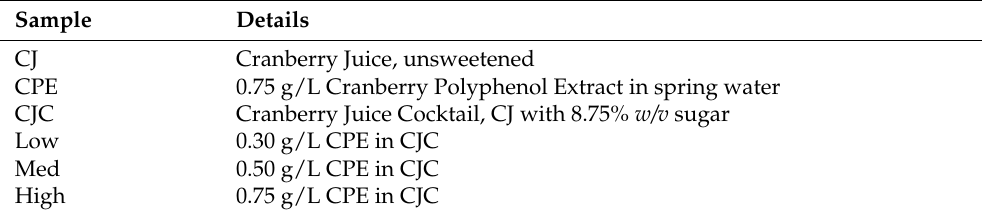
Table 1. Sample formulations.